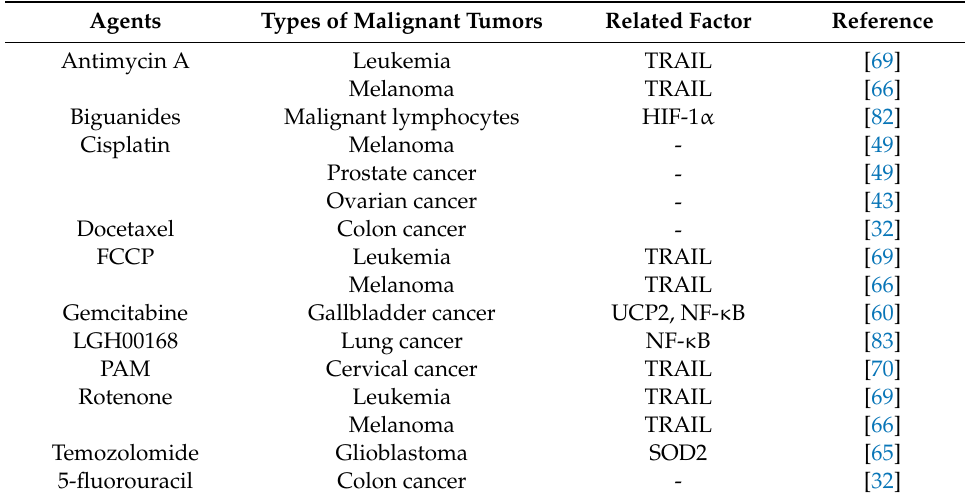
Table 1. Chemical compounds that a ff ect mROS